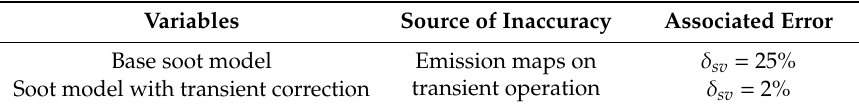
Table 4. Engine-out model variables and associated errors.